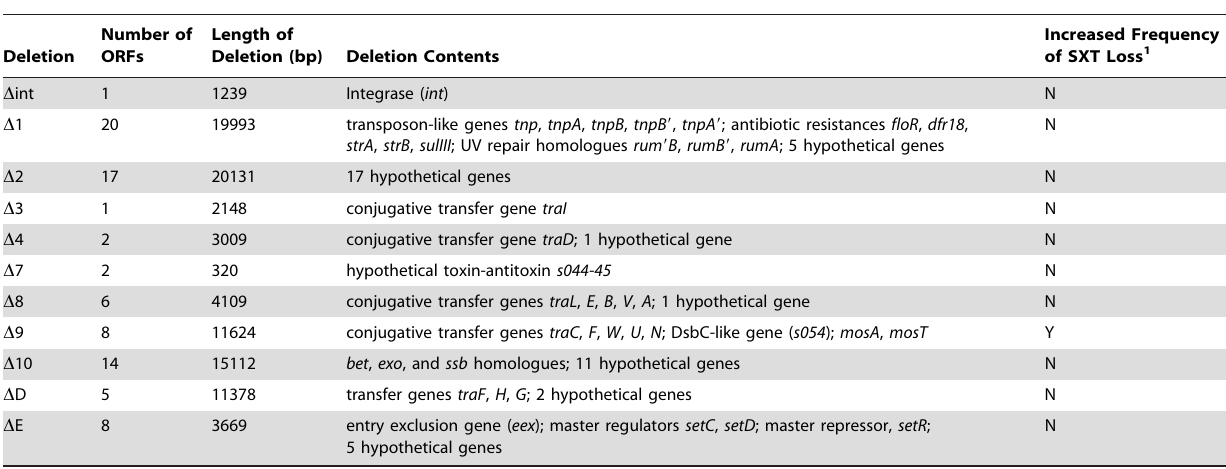
Table 3. Summarized deletions tested for SXT